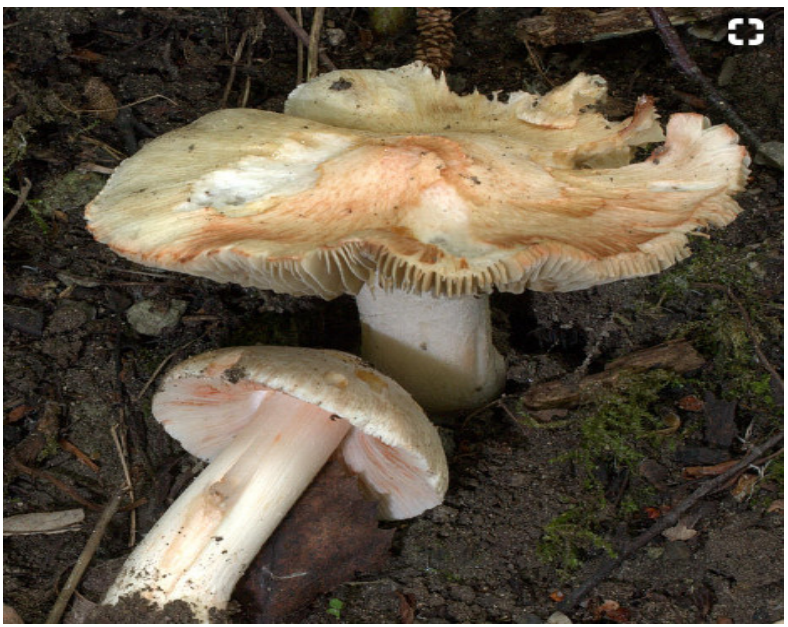
Figure 2. Inocybe erubescens , the most common Inocybe species associated with toxicity in Europe.